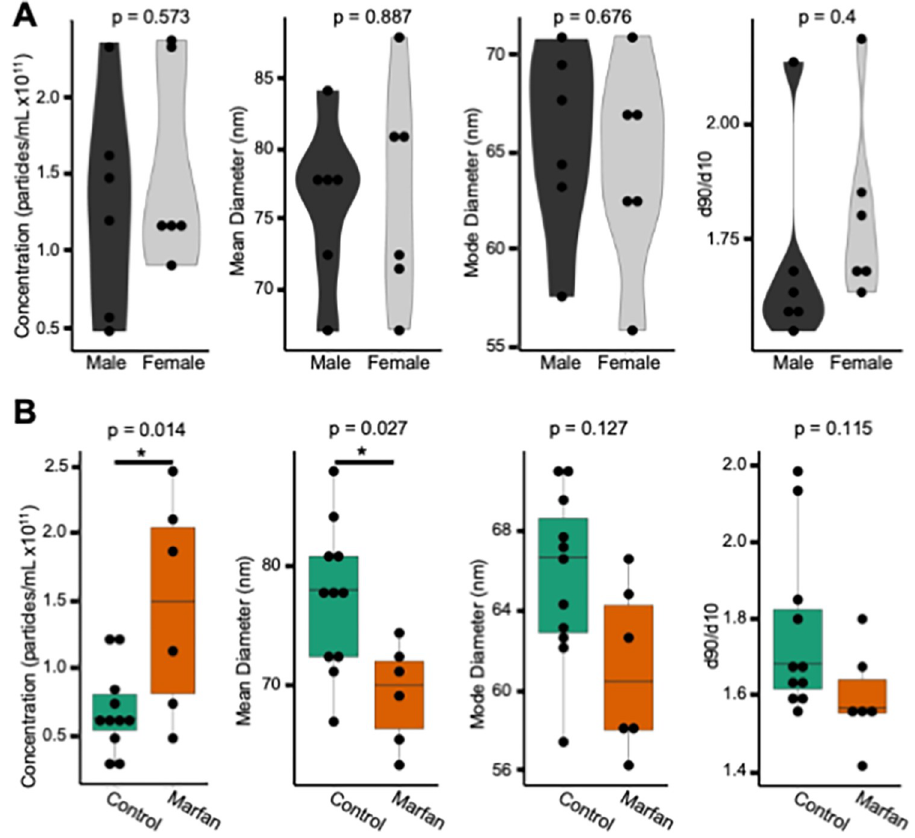
Fig 2. EV concentration and size isolated from human plasma are dependent on disease state. (A) EVs isolated from control patient plasma (n = 12) were measured for concentration (male 0.77 x 10 11 particles/mL, female 0.63 x 10 11 particles/mL), mean diameter of EV particle (male 73.33 nm, female 71.83), mode diameter of EV particles (male 64.58 nm, female 62.67 nm), and d90/d10 ratio (male 1.59, female 1.74). Differences between males (n = 6) and females (n = 6) were assessed with a Student’s t-test. Corresponding p-values are displayed, and median sample values are detailed here. (B) EVs isolated from control plasma (n = 12) and Marfan patient plasma (n = 6) were measured for concentration (control 0.60 x 10 11 particles/mL, Marfan 1.47 x 10 11 particles/mL), mean diameter of EV particle (control 77.75 nm, Marfan 69.92 nm), mode diameter of EV particles (control 65.50 nm, Marfan 60.50 nm), and d90/ d10 ratio (control 1.68, Marfan 1.57). Differences between control and Marfan patients were assessed with a Student’s t-test. Corresponding p-values are displayed, and median sample values are detailed here.